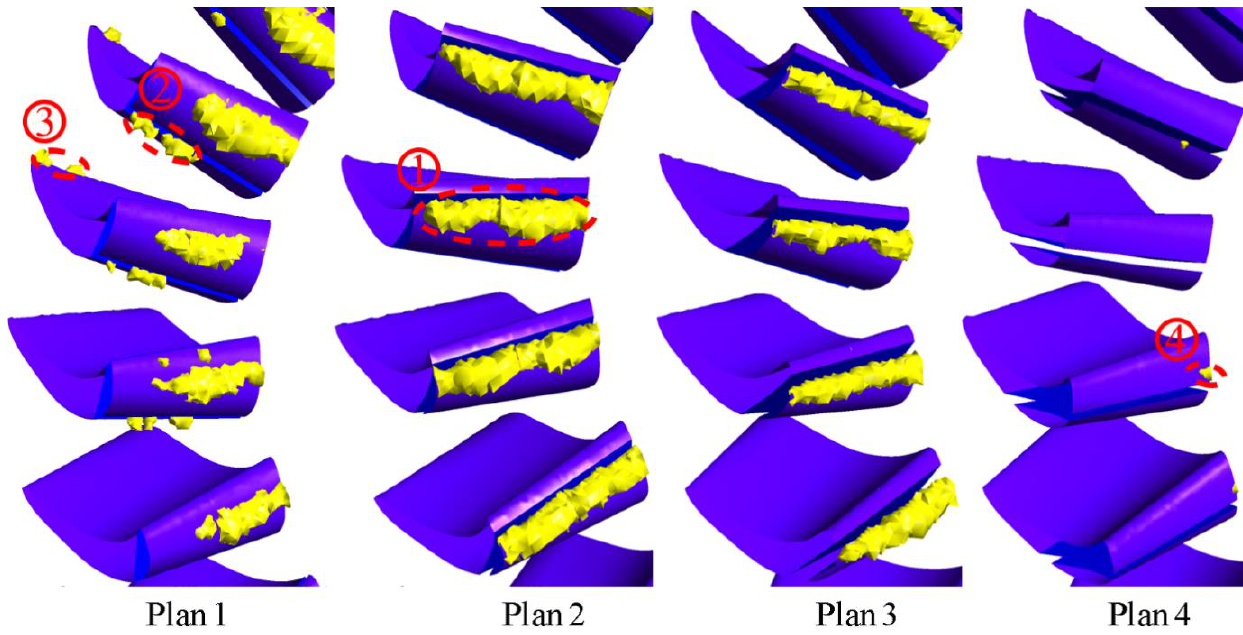
Figure 9. Vapor distribution in various suppression slot stators under stall operating condition in 3D view (1 — attached cavity, 2 — slot cavity, 3 — trailing cavity, 4 — scatter cavity).